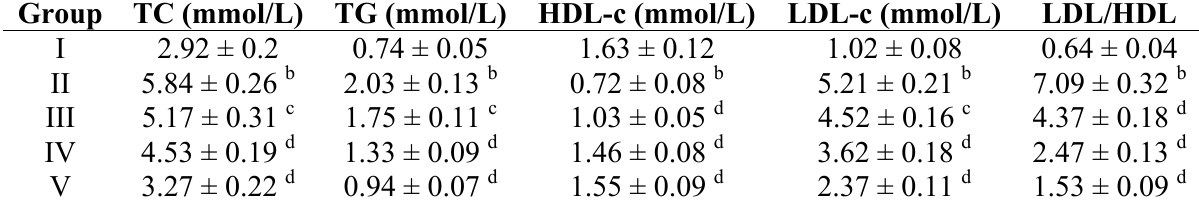
Table 3. Effects of sevoflurane postconditioning on serum lipids